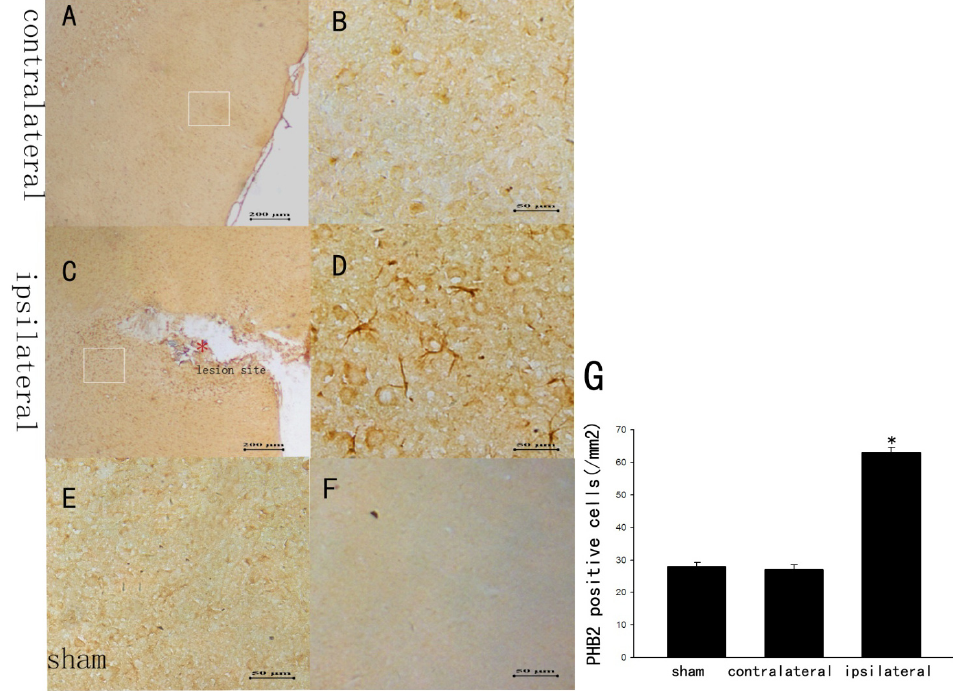
Figure 2. The staining changes of PHB2 immunoreactivity in rat brain cortex after TBI. We performed immunohistochemistry with anti-PHB2 rabbit polyclonal antibody on transverse cryosections of brain cortex and investigated the temporal pattern of PHB2. We could see that the immunostaining of PHB2 was widely distributed throughout the rat brain with a relatively lower level staining in the contralateral and sham brain, and the major cellular morphology of PHB2-positive cells appeared as neuron ( A , B , E ); While the expression pattern was different, that expression was intensive and the cellular morphology appeared as both neurons and astrocytes at day five after TBI ( C , D ); Quantitative analysis documented that there was a dramatic elevation of PHB2-positive cells after TBI ( G ); ( F ) Immunostaining of negative control for PHB2. Error bars represent SEM, Scale bars: 200 μ m ( A , C